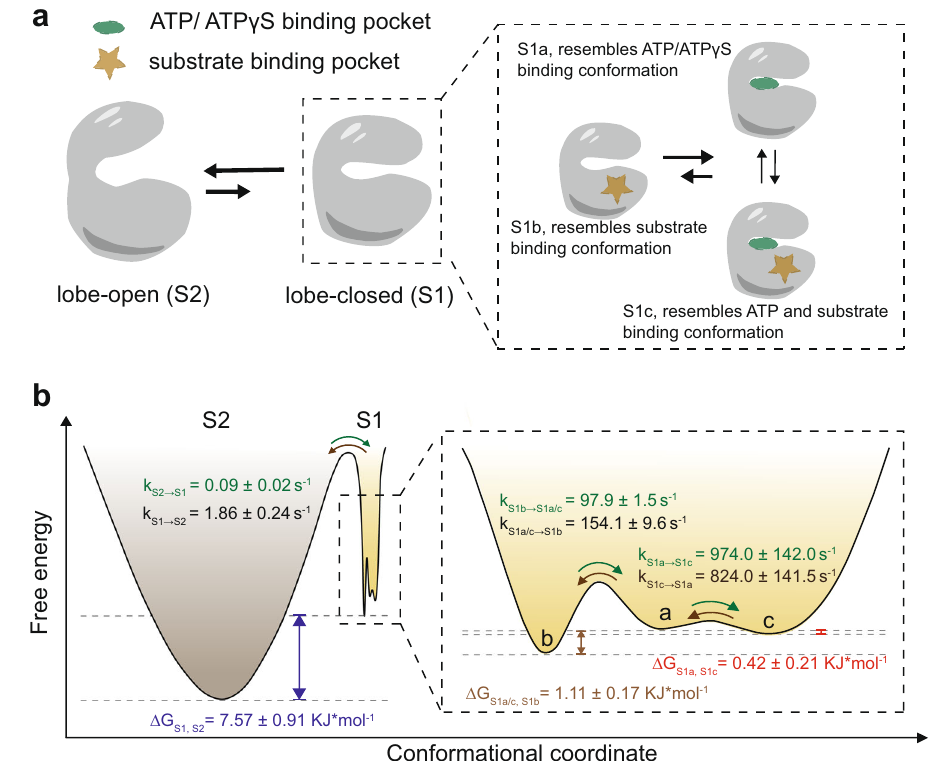
Fig. 6 Conformational dynamics of apo Abl kinase domain. a Models of apo Abl kinase domain conformational changes. Two major conformations (S1: lobe-closed, S2: lobe-open) and three S1 conformational sub-states (S1a, S1b, S1c) which resemble substrate or substrate combination binding states are shown. b Schematics of the conformational energy landscape of apo N4pos Abl. S1 (yellow) and S2 (brown) indicate the two major conformations, lobe- closed and lobe-open, respectively. S1 conformational sub-states, S1a, S1b, S1c are indicated by a, b, c, respectively. State transition rate constant (k), and free energy difference ( Δ G) between states are shown on the